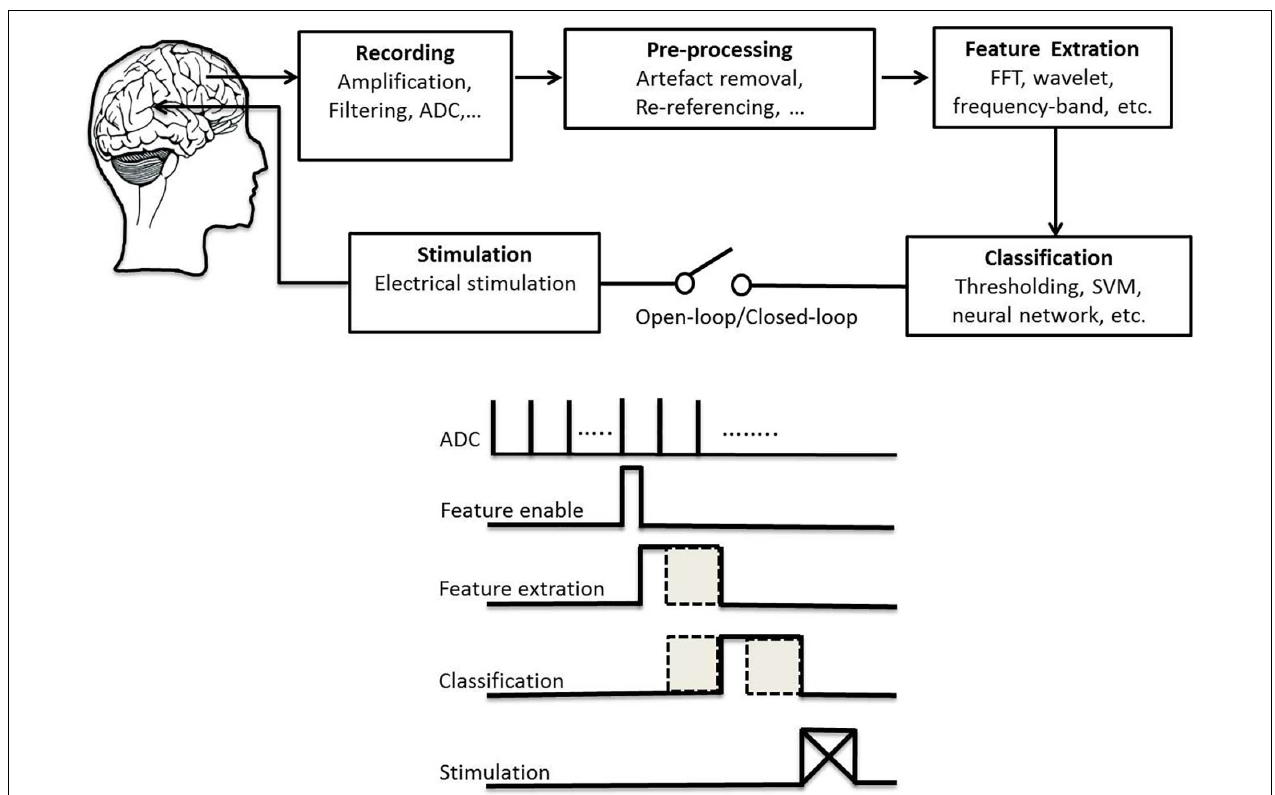
FIGURE 1 | Schematic plot of a technical system for deep brain stimulation (top) and its flowchart of signal processing (bottom) .